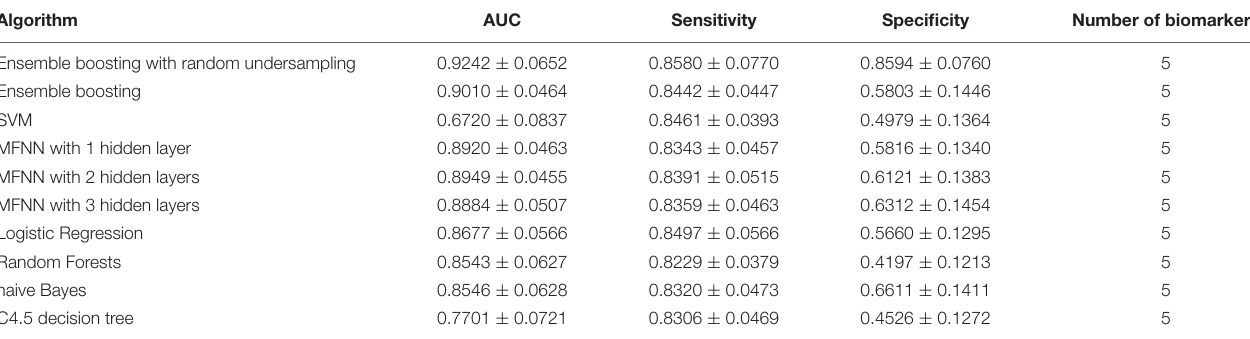
TABLE 2 | The results of repeated 10-fold cross-validation experiments for differentiating schizophrenia patients from healthy individuals using ensemble boosting with random undersampling, ensemble boosting, SVM, MFNNs, logistic regression, random forests, naive Bayes, and C4.5 decision tree with biomarkers such as DAO protein levels, G72 protein levels, melatonin protein levels, age, and gender. Algorithm AUC Sensitivity Specificity Number of